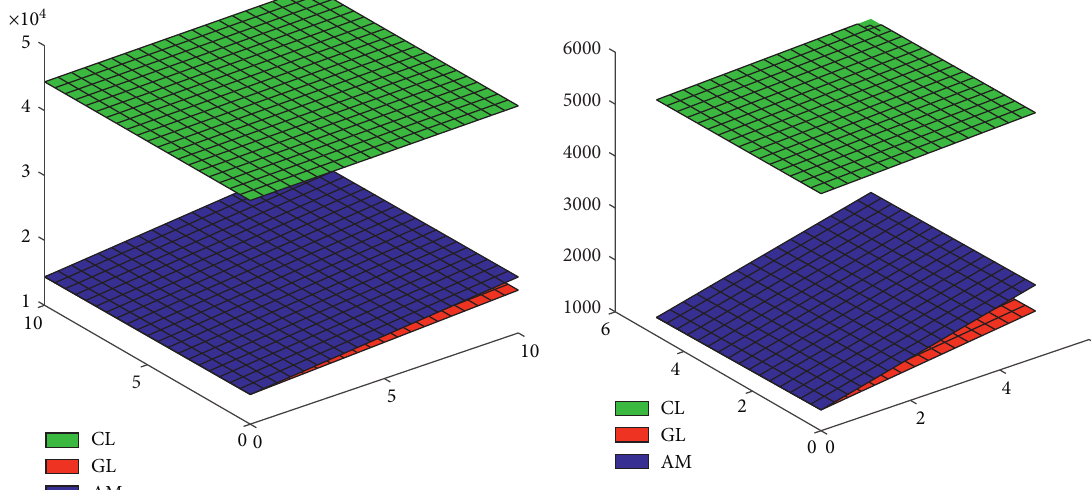
Figure 12: Comparison of CL l